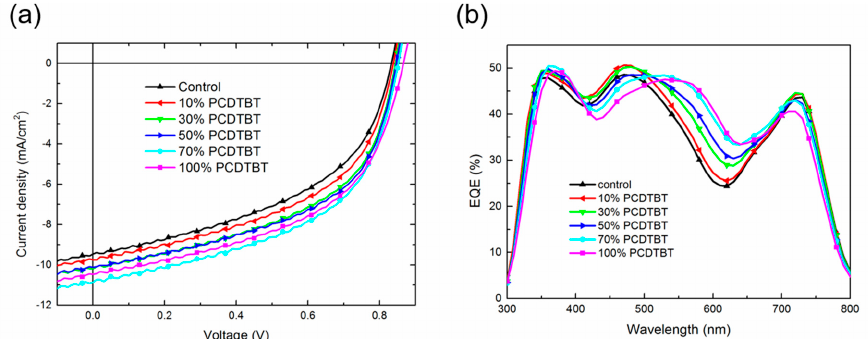
Figure 2. Device performance. ( a ) The current density–voltage (J–V) characteristics of binary and ternary devices; ( b ) The external quantum efficiency (EQE) curves of devices. Table 1. Photovoltaic parameters of binary and LQ-51/PCDTBT/PC 71 BM ternary solar cells, measured under AM 1.5 G solar illumination (100 mW cm − 2 ). R Sh and R S extracted from illuminated J–V